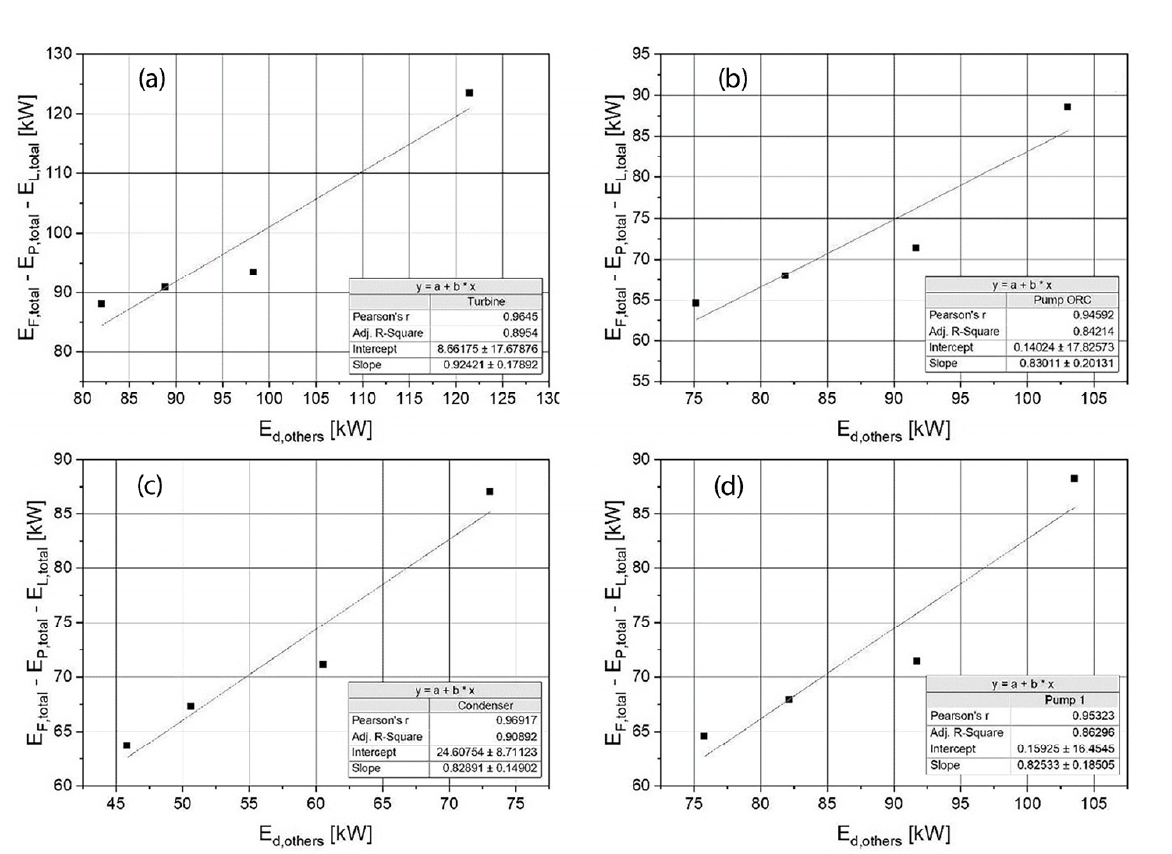
Figure 6. Endogenous exergy of the main components ( a ) turbine, ( b ) pump-2, ( c ) condenser, and ( d ) pump-1.